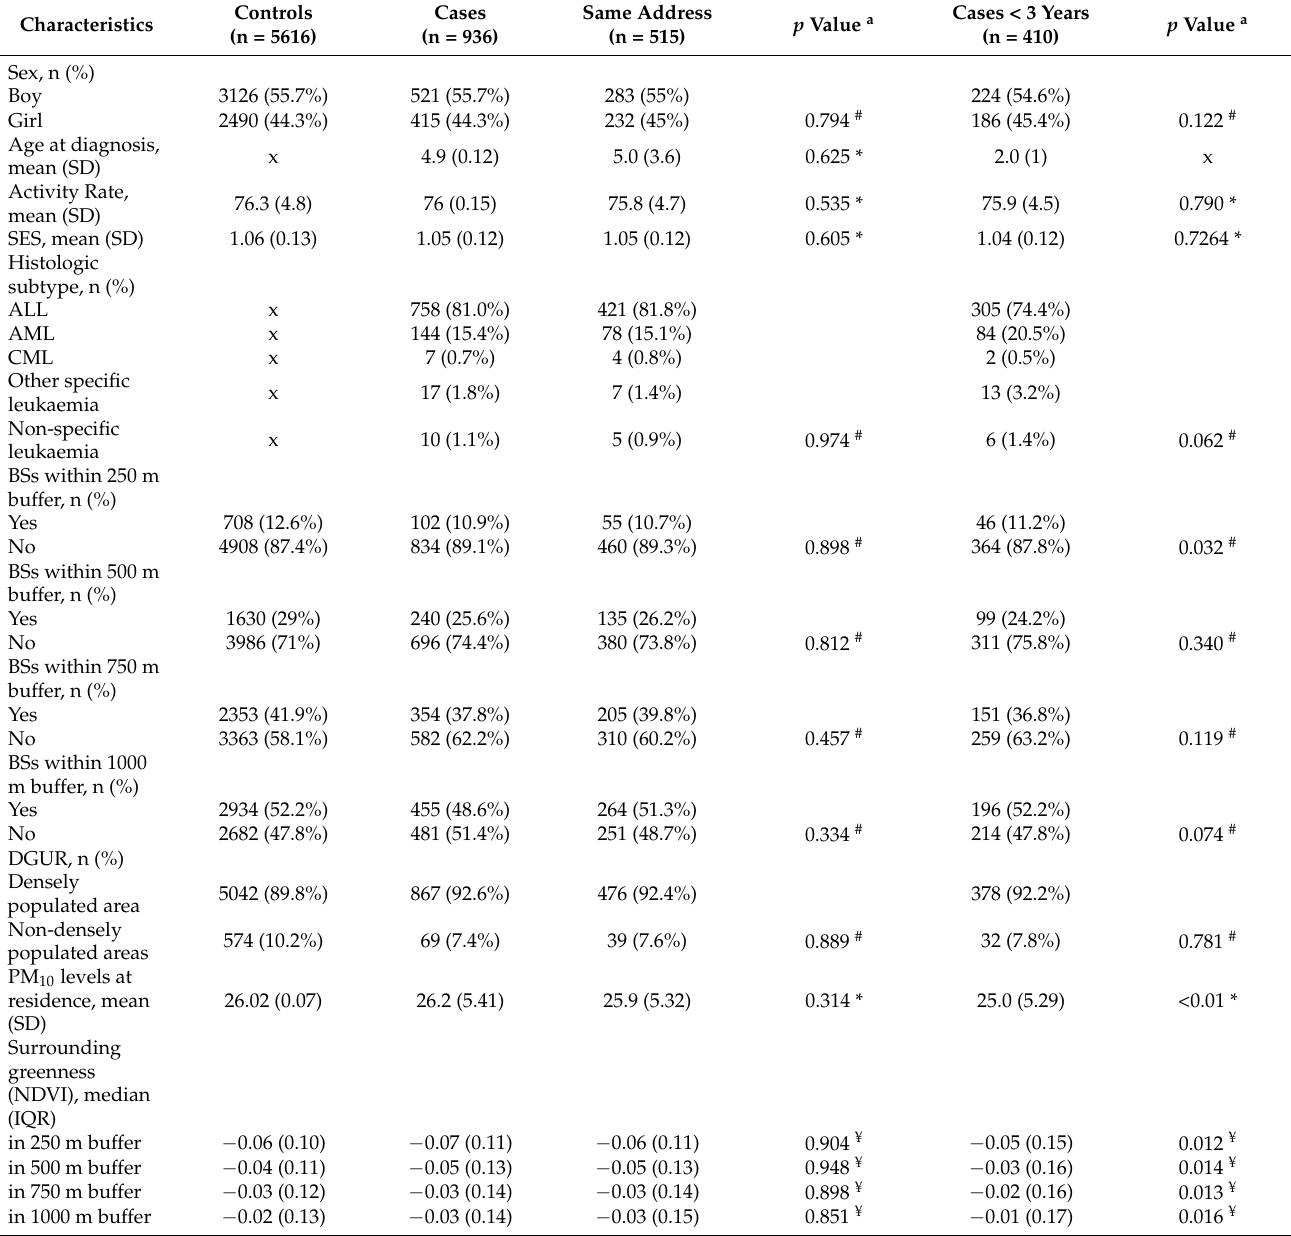
Table 1. Childhood leukaemia cases, sensitivity groups, and controls’